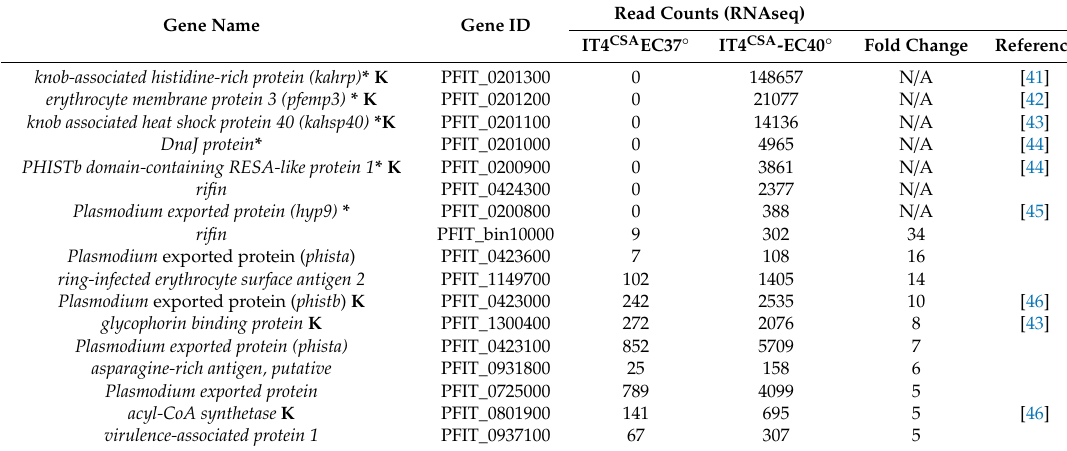
Table 2. Upregulated genes (fold change ≥ 5) in ring-stage IT4 CSA EC40 ◦ parasites compared to ring-stage IT4 CSA EC37 ◦ parasites (padj <